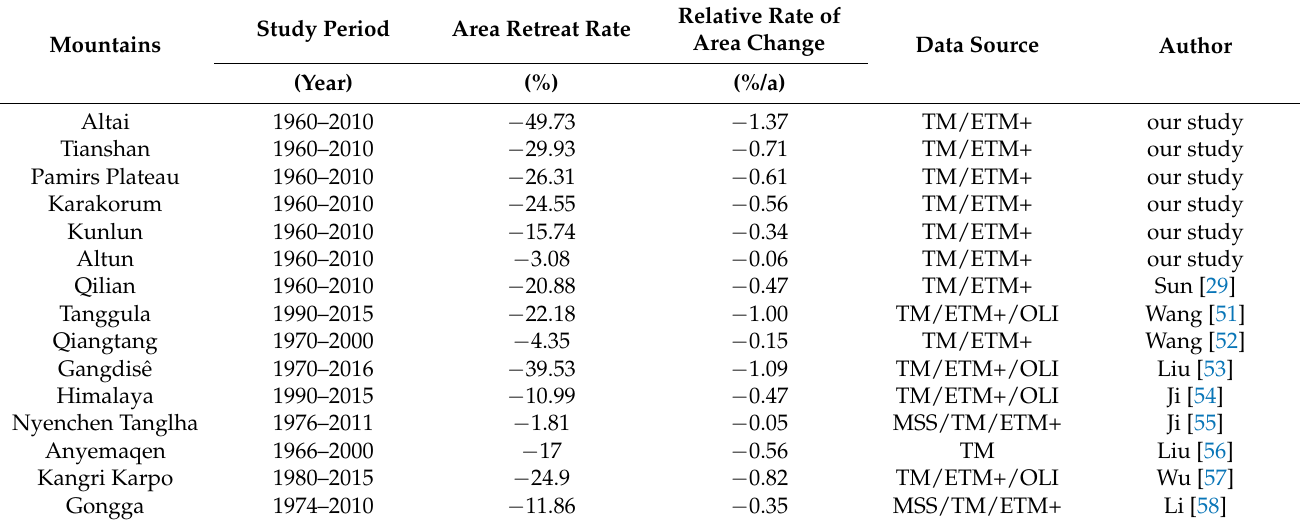
Table 5. Statistics of glacier changes in western China in recent